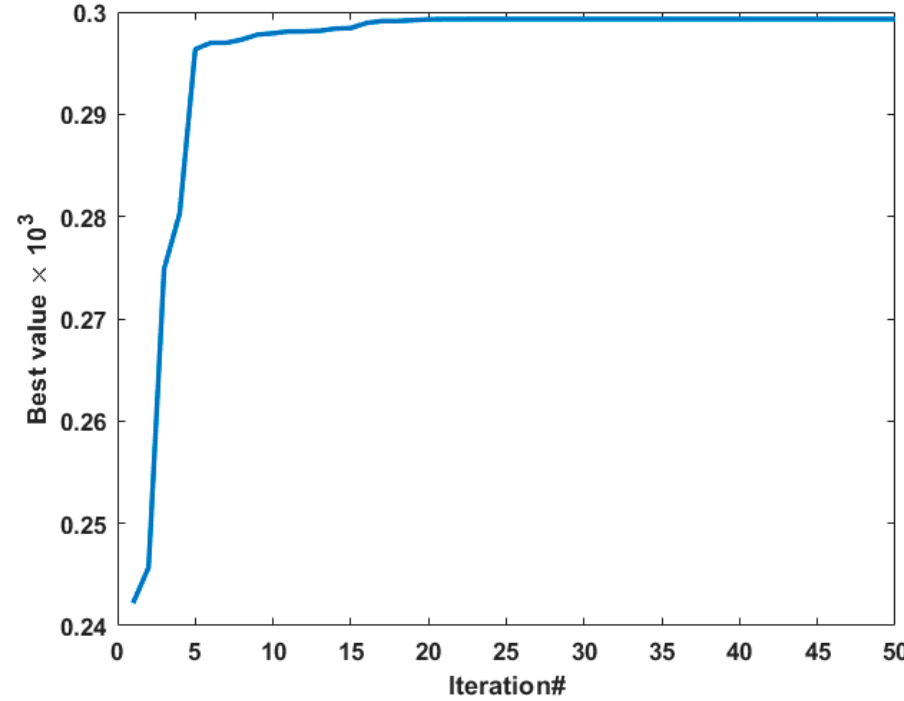
Figure 7. The optimum value of H 2 production after 50 iterations.